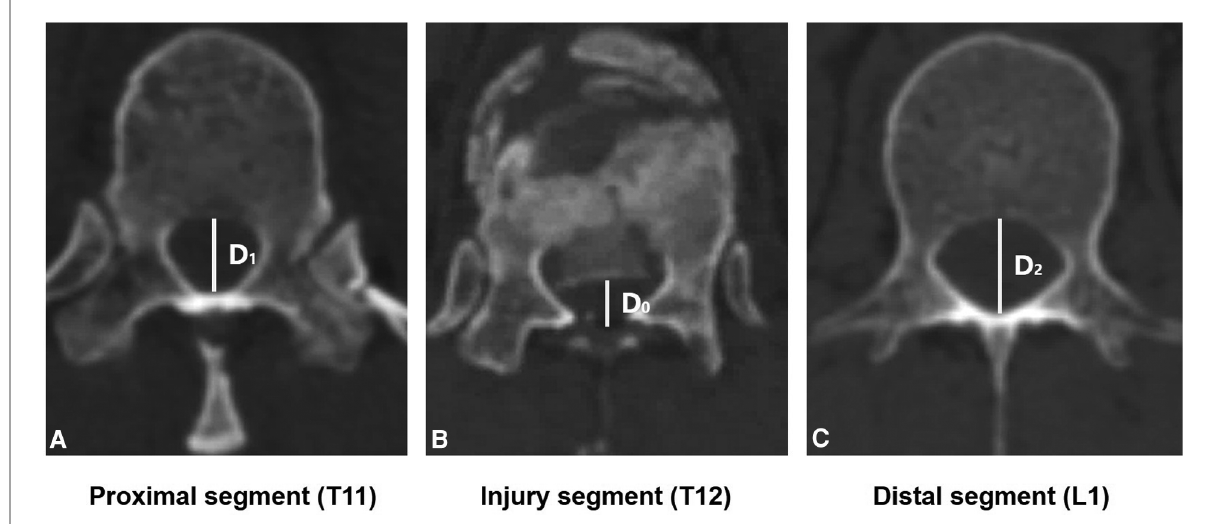
FIGURE 1 The midsagittal diameter of spinal canal measurement. D0 was the midsagittal diameter of the injured level ’ s spinal canal (T12). D1 and D2 were the midsagittal diameters of the spinal canal at the levels above (T11) and below (L1) the injured level.